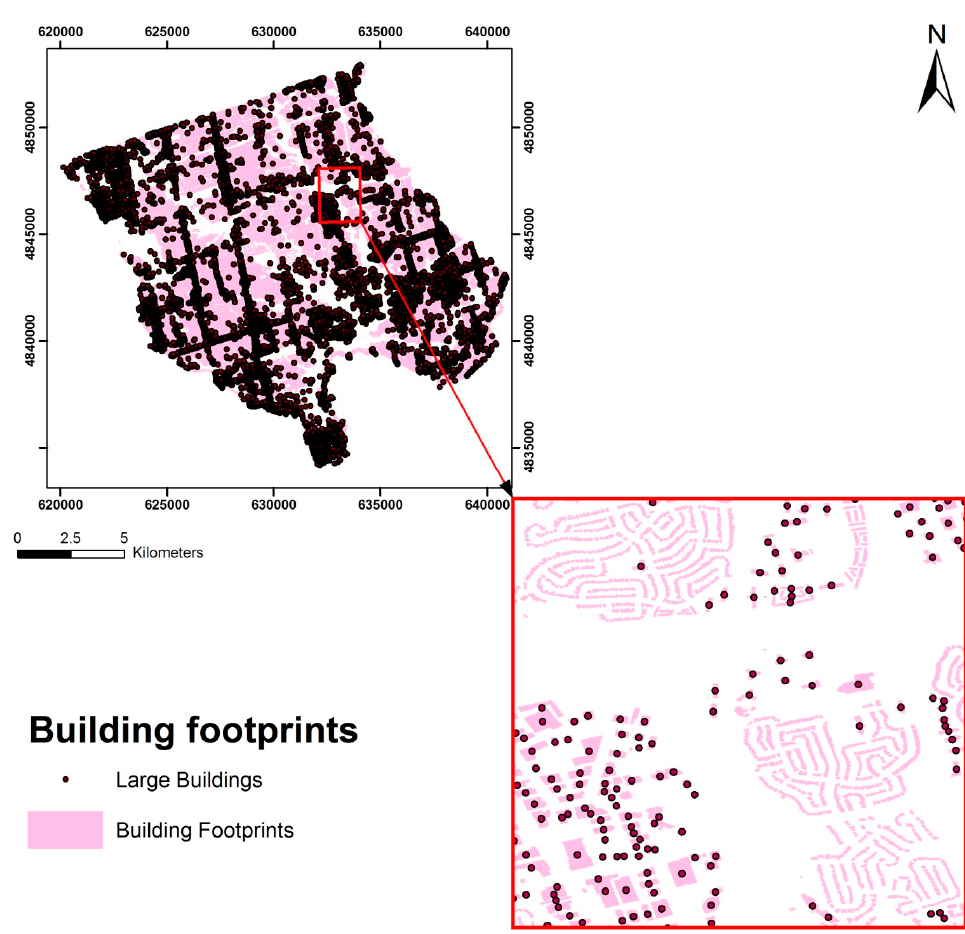
Figure 12. Building footprints and points of large buildings.